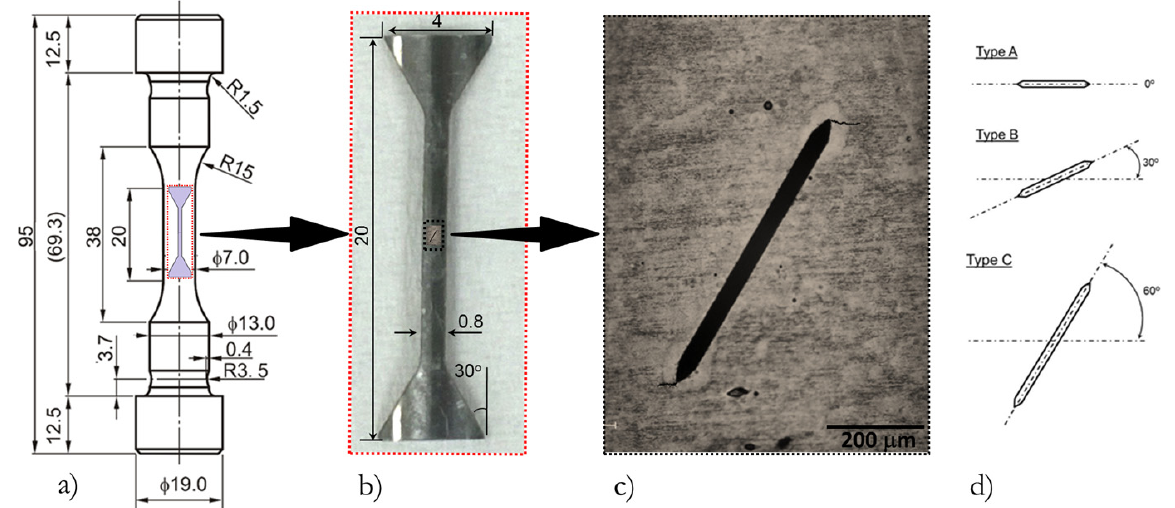
Figure 1: (a) Fatigue specimen (b) tomography specimen extracted from the fatigue specimen (c) notch and non-propagating cracks located in the small specimen (d) types of defects and tilting angles.